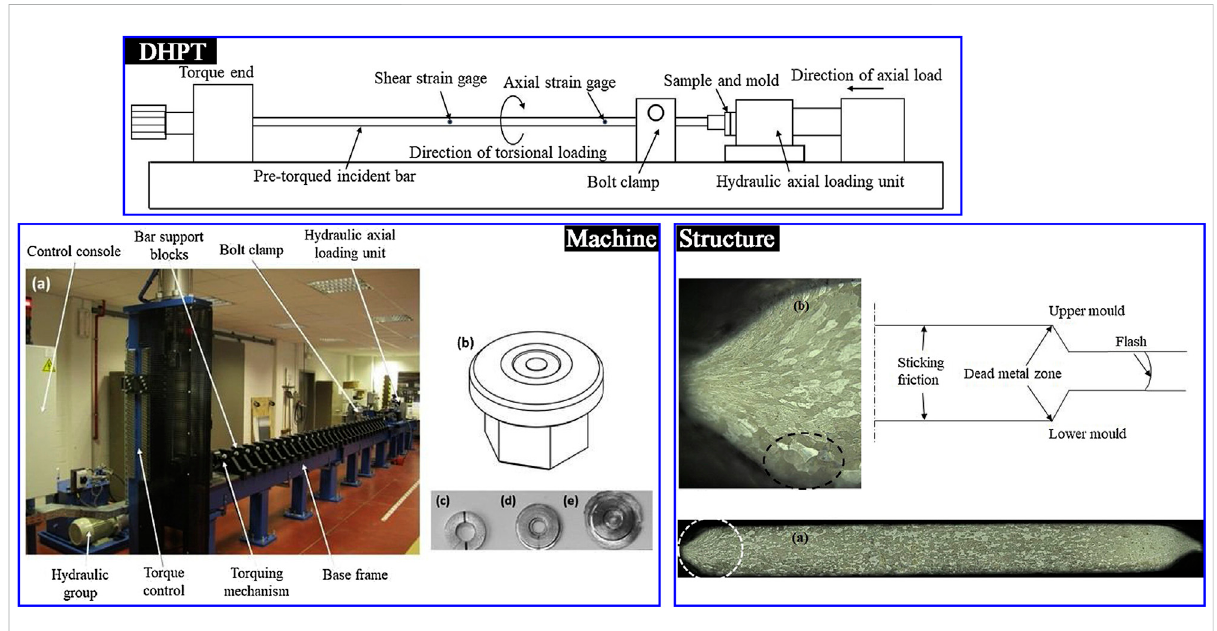
FIGURE 14 Illustration of DHPT, the used machine, and resultant microstructures of pure Al (Verleysen and Lanjewar,